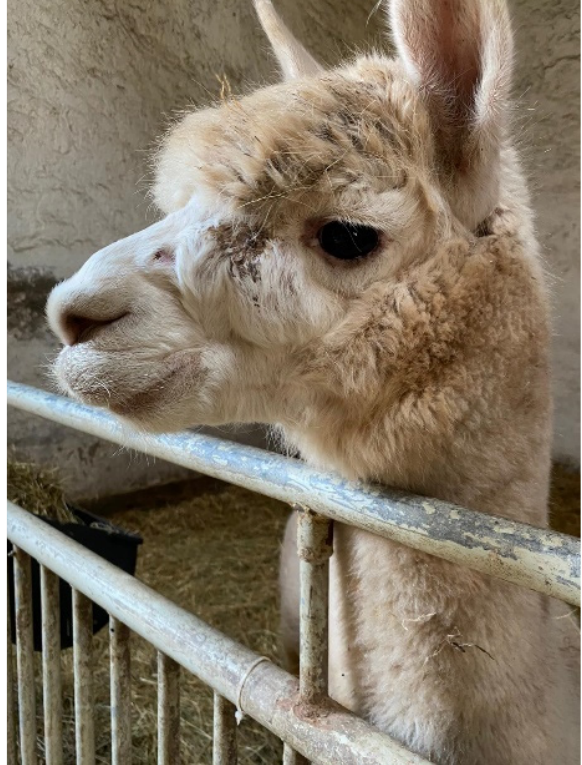
Figure 1. Abscess on the upper jaw below the eye caused by C. pseudotuberculosis (stallion S8).